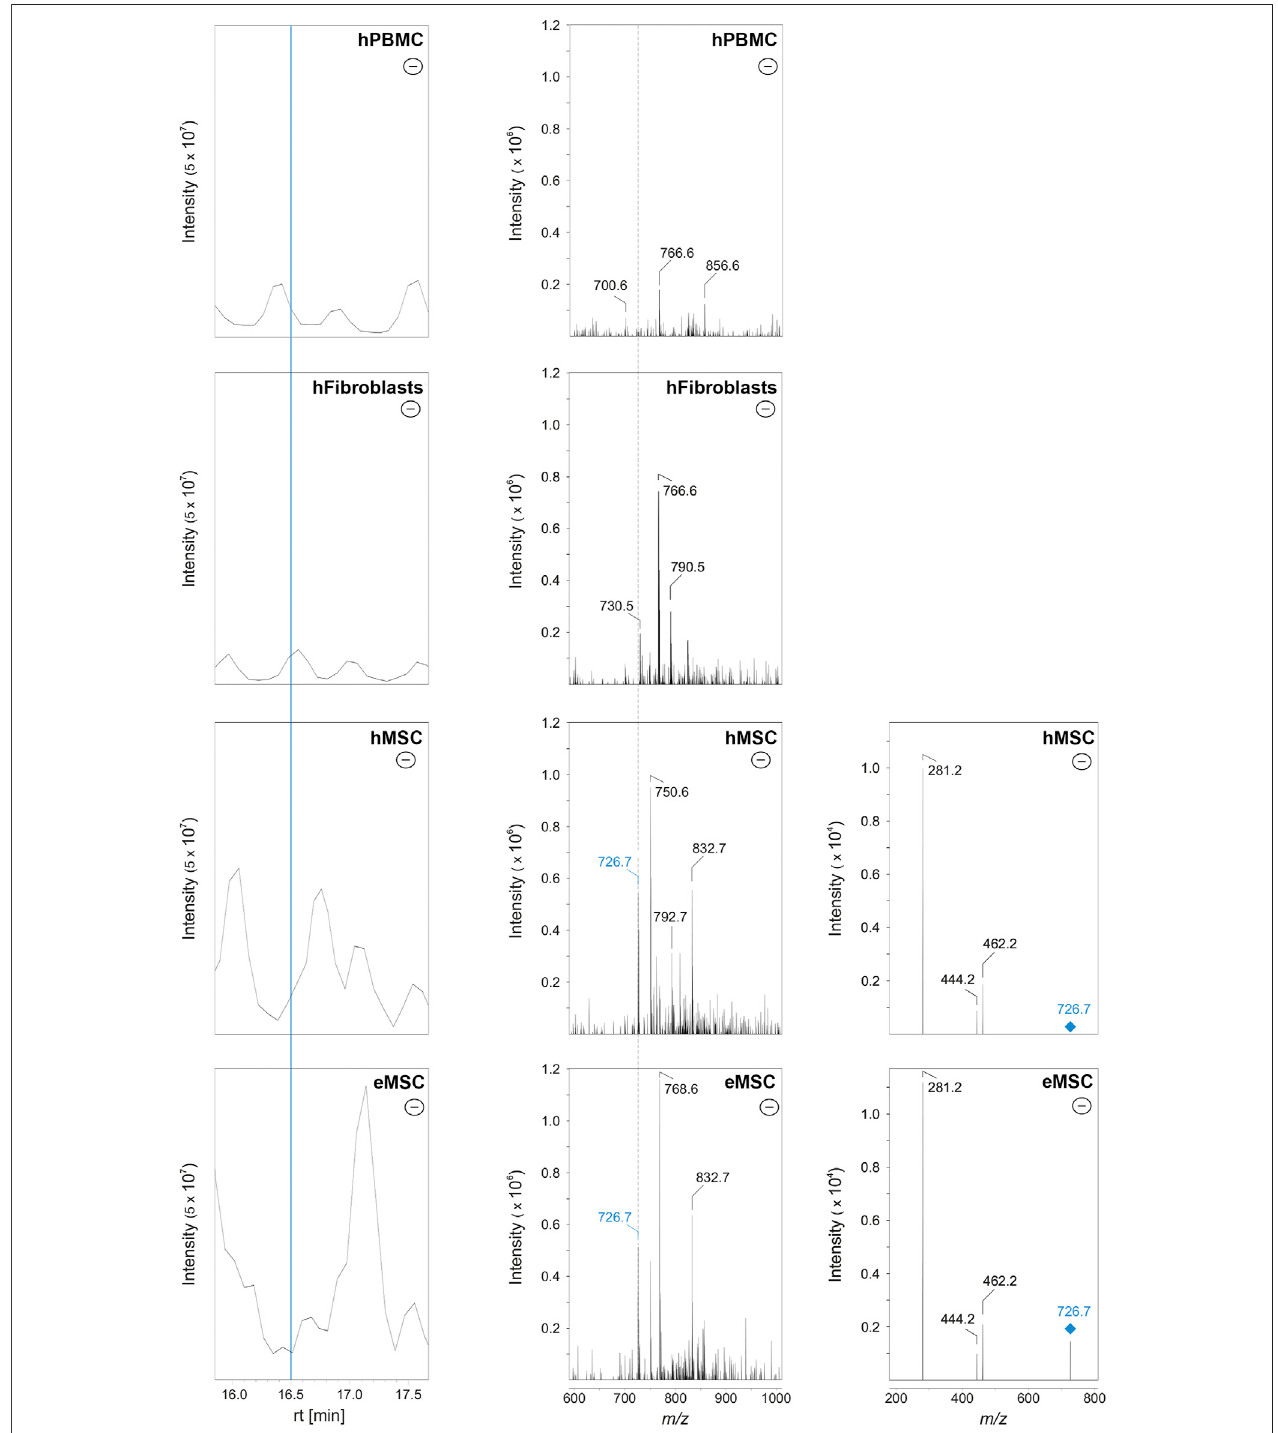
FIGURE 4 | Identi fi cation of PE O-36:3 by liquid chromatography coupled to mass spectrometry in MSC. Left row: base peak chromatograms in the negative ionizationmodeofhPBMC, hFibroblasts,hMSCandeMSCinaretentiontime(rt)from16.0to17.5 min.TheMSCwerecultured inthesamestandardmediumwithFBS as the hFibroblasts. The blue line indicates the rt at 16.5 min. Middle row: Corresponding mass spectra of hPBMC, hFibroblasts, hMSC and eMSC after negative ionization at rt 16.5 min showing a mass-to-charge (m/z) window from 600 to 1,000. The labels indicate those m/z values which were automatically picked for further tandem mass spectrometry (MS/MS) measurements (for further information see chapter: material and methods). Both the hMSC and eMSC samples lead to the signalwithm/z726.7(labeledinblue).InhPBMC andhFibroblasts, signalat m/z726.6wascompletely absent(indicatedbythedashed line). Rightrow:MS/MSspectra